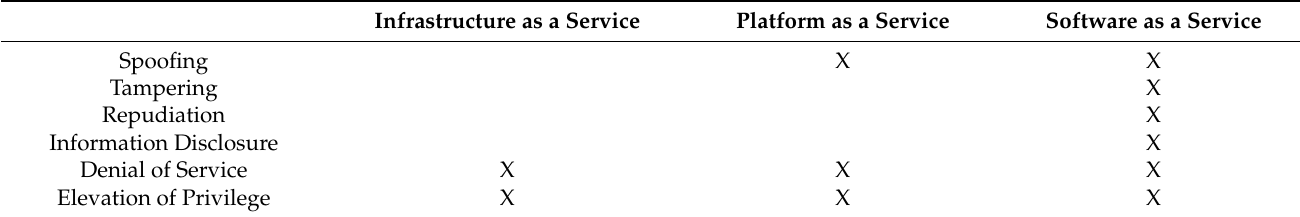
Table 5. Cloud service delivery STRIDE